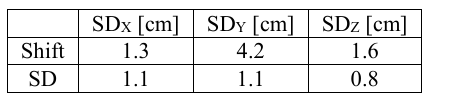
Table 11. Estimated shift and standard deviations between RTK GNSS and terrestrial method Table 13. Estimated standard deviations between terrestrial